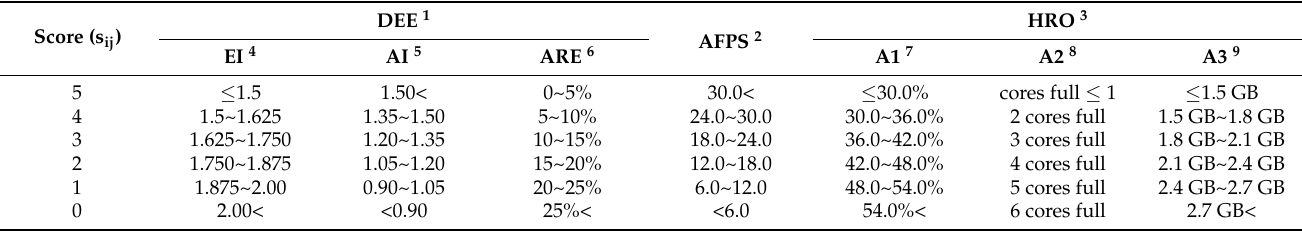
Table 1. Evaluation criteria of test items over vineyard dataset.